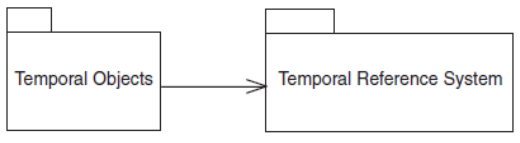
Figure 1 Packages of the ISO 19108 temporal schema